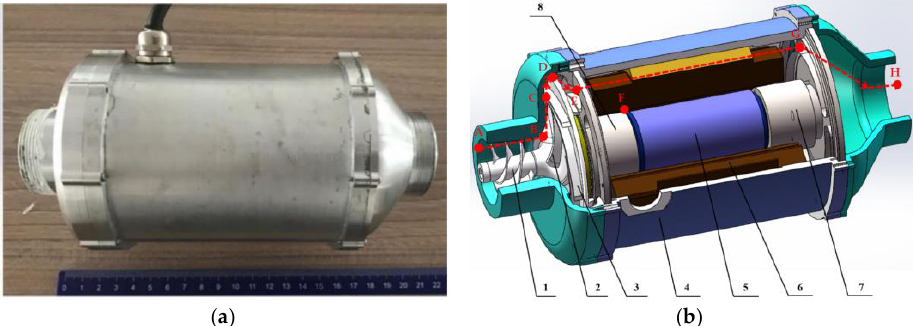
Figure 1. Image of the low specific speed high-speed centrifugal pump ( a ) and schematic of low specific speed high-speed centrifugal pump; ( b ): 1 — inducer; 2 — impeller; 3 — diffuser; 4 — casing; 5 — main axle; 6 — motor stator; 7 — tail end fixed bearing; 8 — front fixed bearing.